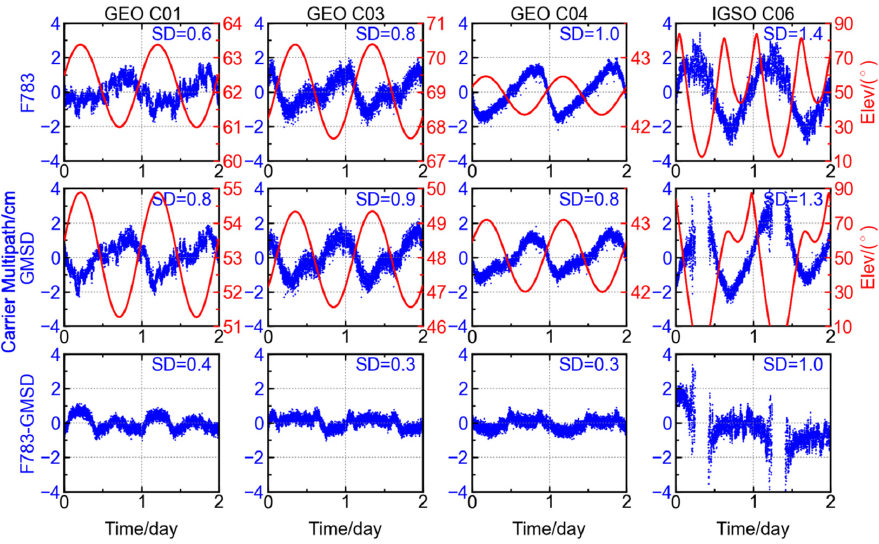
Figure 11. GFIF combinations at station F783 ( top row ), station GMSD ( middle row ) and differencing result between the two stations ( bottom row ) for different BDS satellites, the red curve showing the satellite elevation.